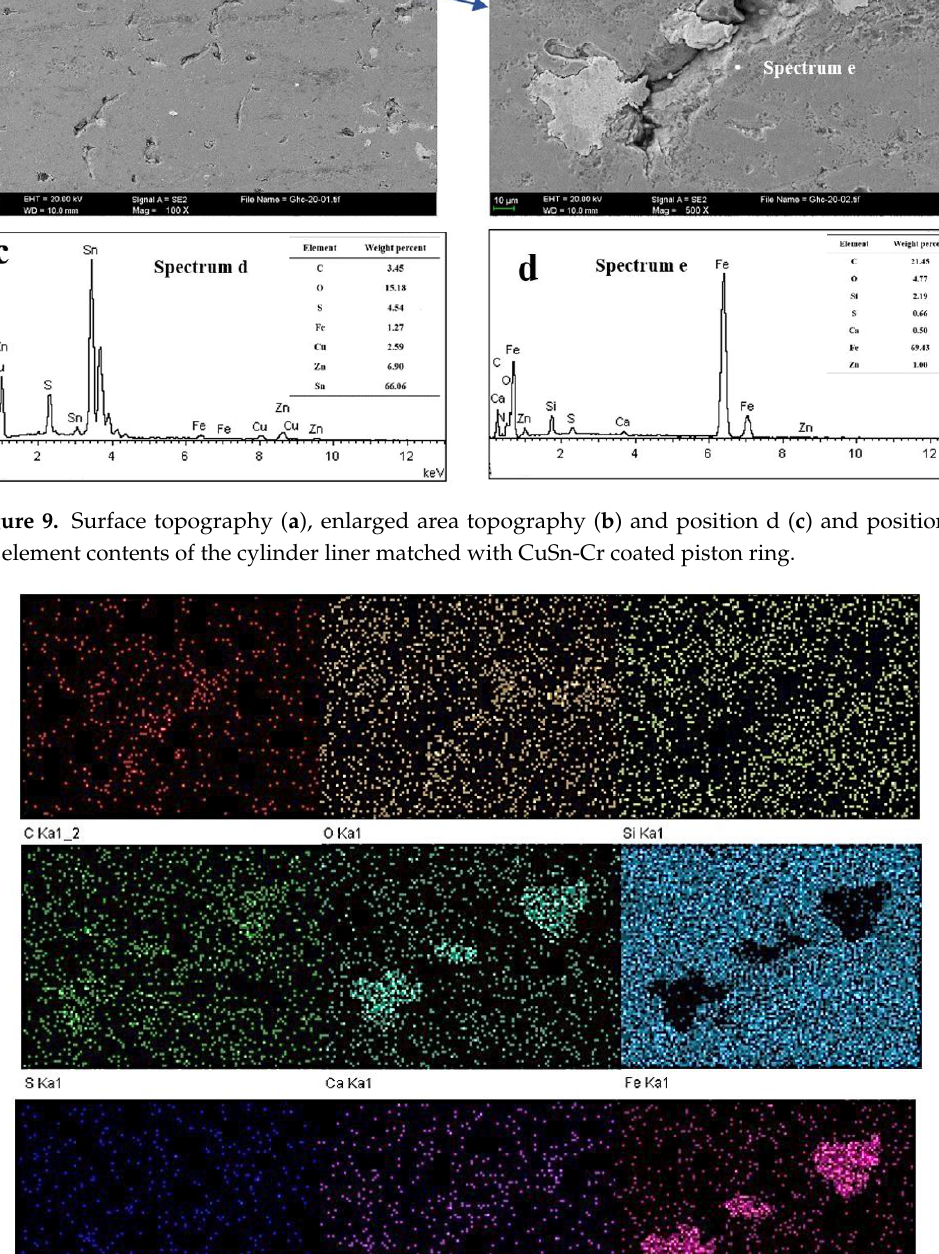
Figure 10. Elemental distribution mapping on the worn surface of Figure 9b.